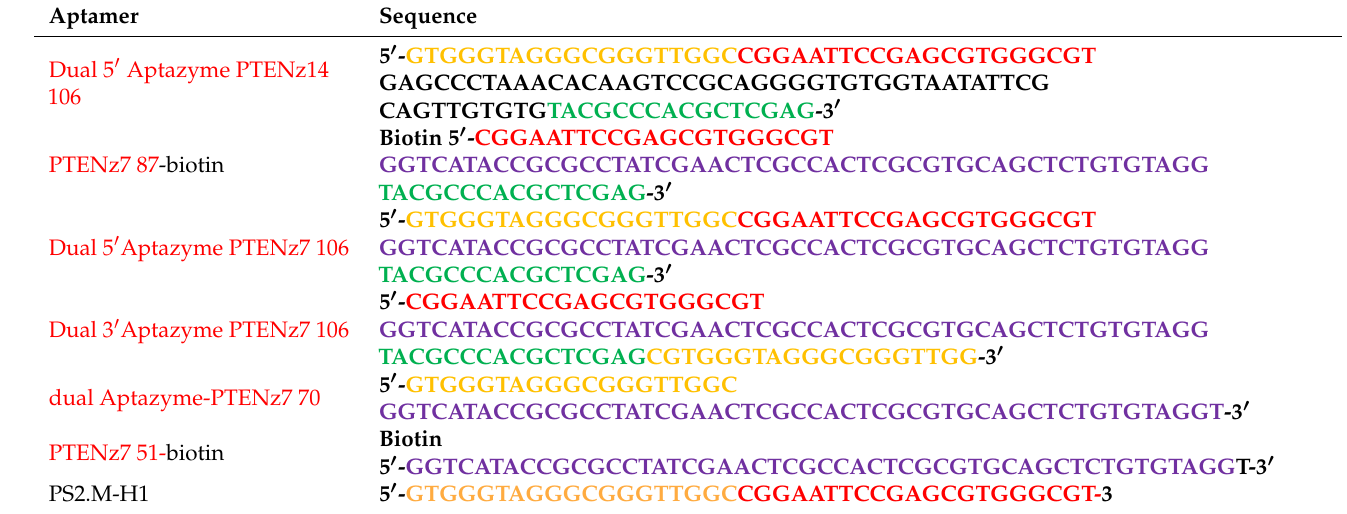
Table 1. DNA oligonucleotides used in the construction of the aptamer-DNAzyme, aptamer-HRP and DNAzyme peroxidase. Color code: Orange = PS2.M; Red and Green = 5 (cid:48) and 3 (cid:48) STEM linker; Black/Purple = target recognition